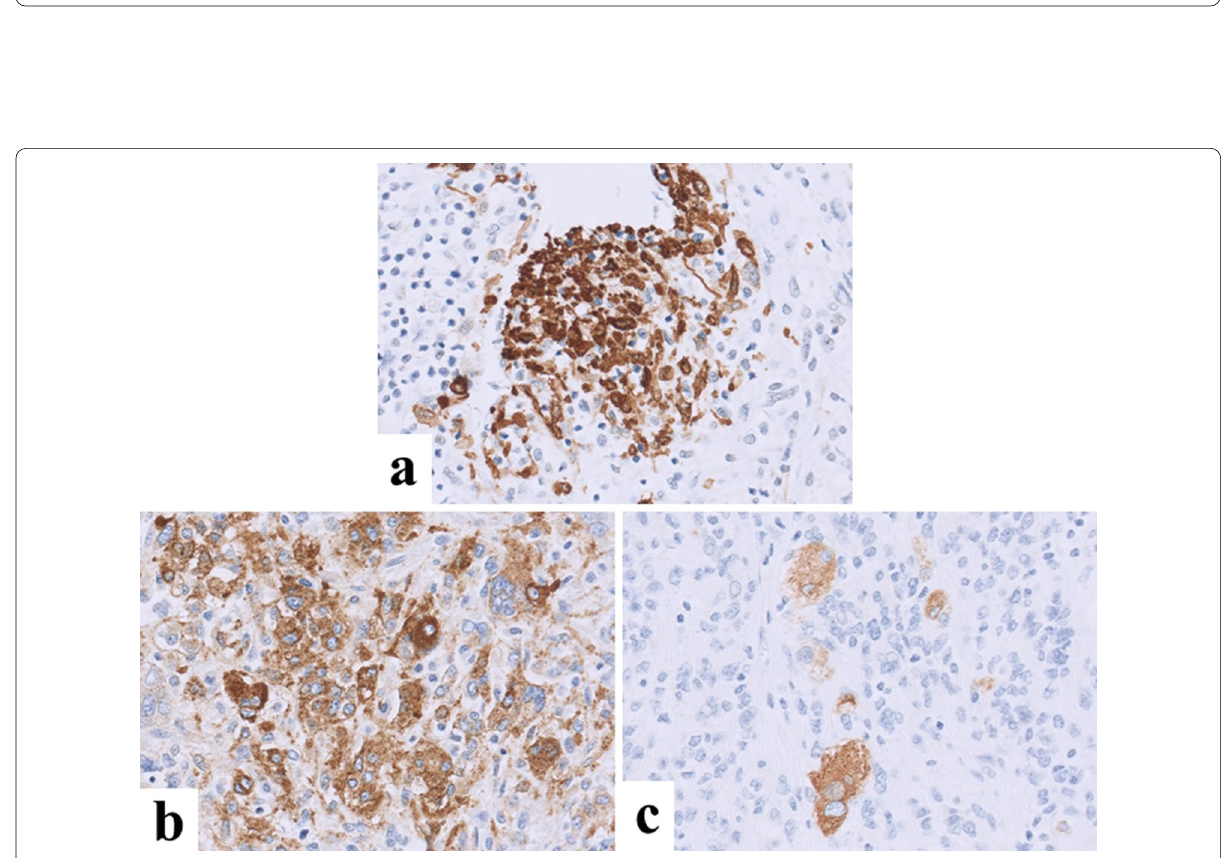
Fig. 6 Immunohistochemical findings. Immunohistochemistry showed α-SMA ( a ) and melan A ( c ) were positive in some cells, while HMB-45 ( b ) was positive in about 50% of